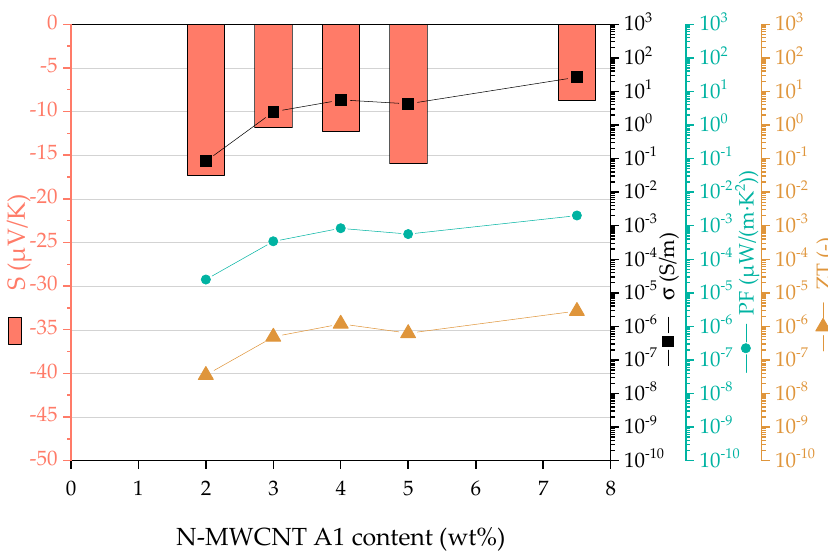
Figure 2. Thermoelectric properties (40 °C) of PP/N-MWCNT A1 composites at different nanotube contents.